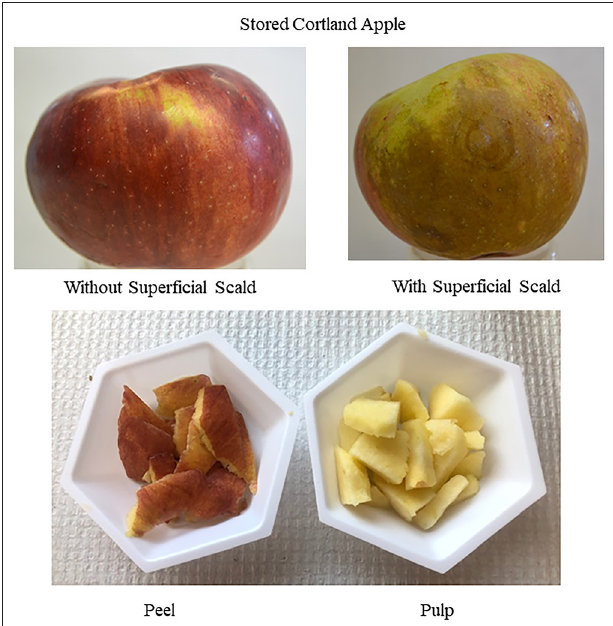
FIGURE 1 | Stored “Cortland” apple with peel and pulp extracted separately using cold water and 12% ethanol.